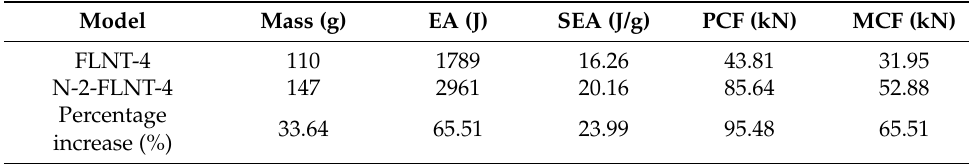
Figure 24. The deformation modes: ( a ) N-1-FLNT-4; ( b ) N-2-FLNT-4. Table 12. Energy absorption properties for N-FLNT-4 and